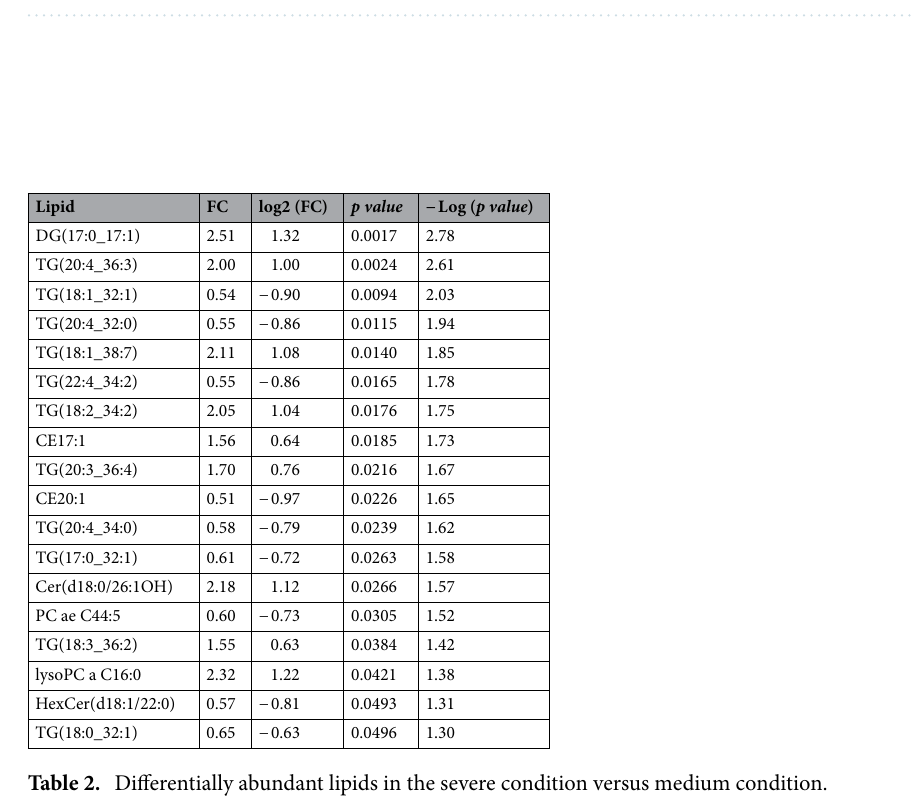
Table 1. Differentially abundant lipids in the severe condition versus mild condition.